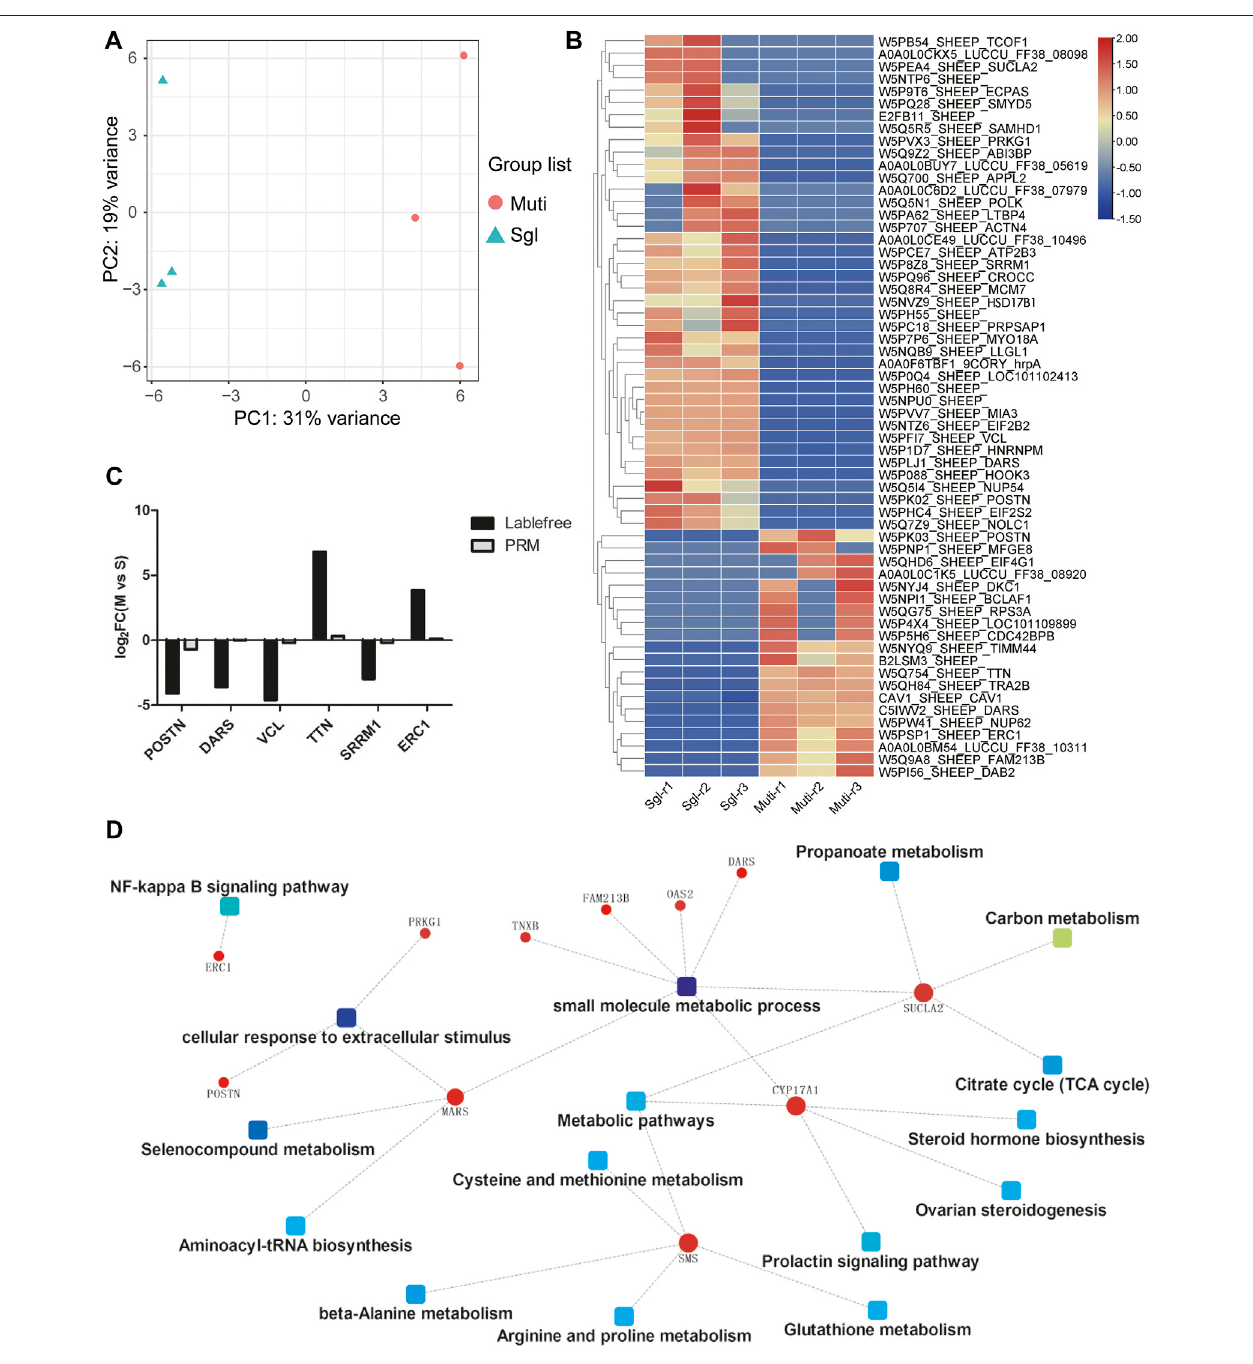
FIGURE 3 | Proteomics analysis results. Mult, Small Tail Han sheep group, n (cid:1) 3; Sgl, Xinji fi ne wool sheep group, n (cid:1) 3; PRM, Parallel reaction monitoring. (A) Principal component analysis plots for all the samples. PC1, principal component 1; PC2, principal component 2. (B) The heatmap shows the levels of these 60 differentially expressed proteins (red, high expression; blue, low expression). (C) PRM veri fi cation of label-free differentially expressed protein expression. (D) Protein – protein interaction network showing the related signaling pathways.